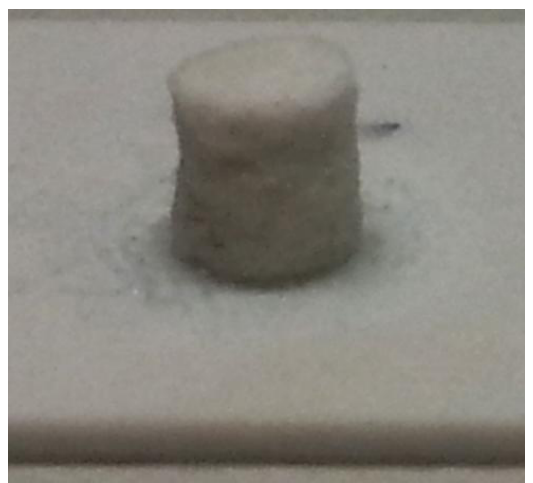
Figure 3. Ash sample of jatropha wood after the test (1600 °C).